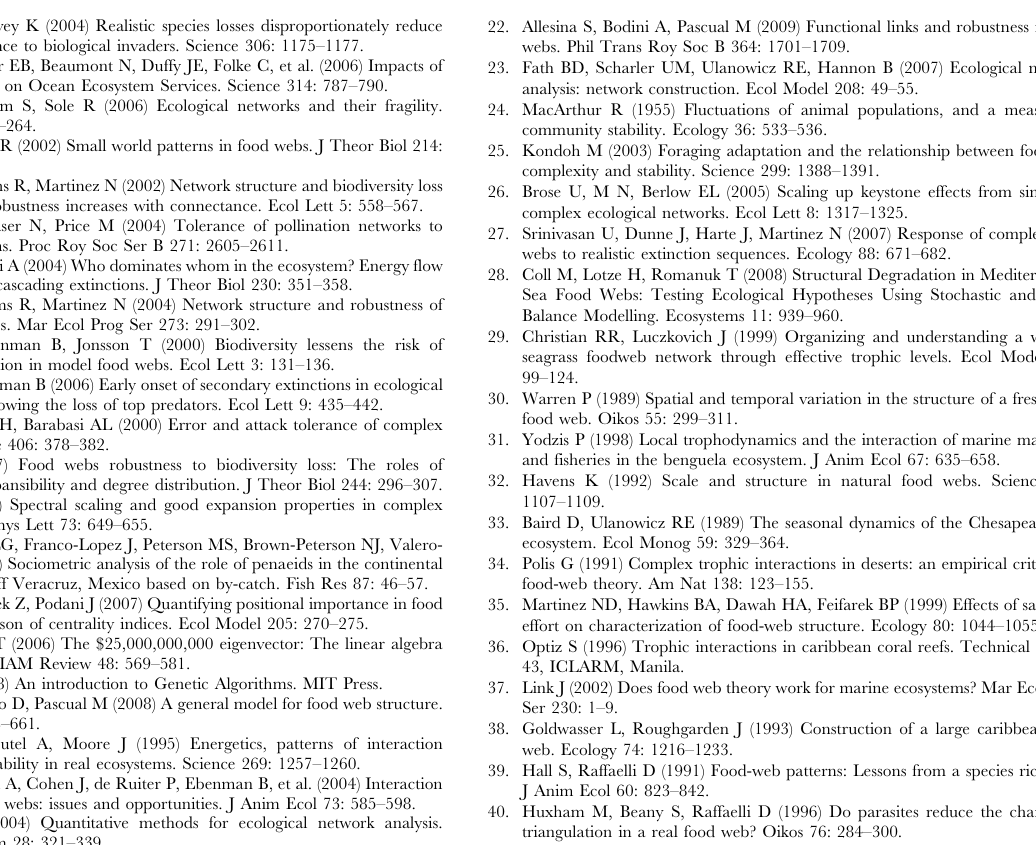
biomass per year per hectare. Red links represent biomass losses experienced by the species. Figure S2 Relationship between the size of flows in the food web (Fig. S1) and the values of the eigenvalue vi. The y axis is the sum of all flows entering (or exiting) a species. The x axis is the corresponding value in the eigenvector v . The logarithms of both values are shown in the graph to better discriminate the